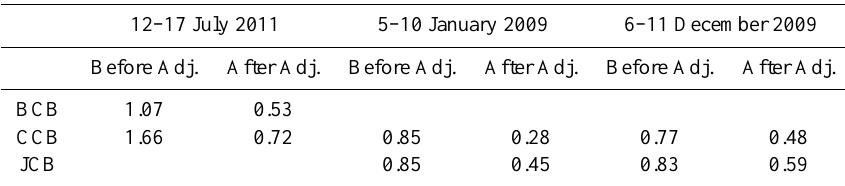
Before Adj. After Adj. Before Adj. After Adj. Before Adj. After